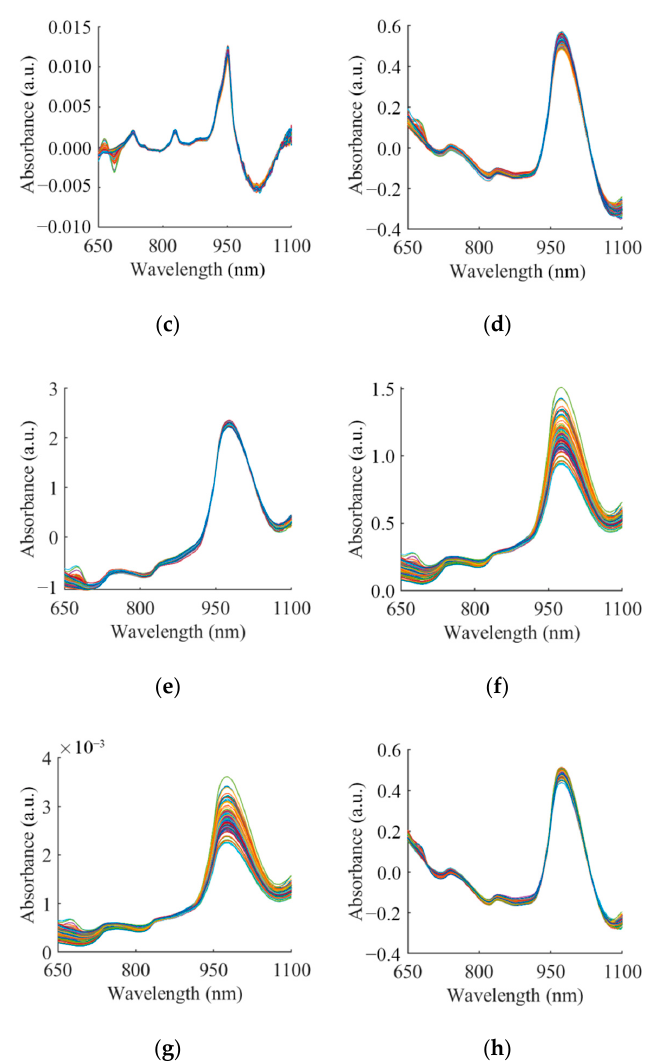
Figure 5. ( a )The raw absorbance spectra (RAW) and the spectra after ( b ) normalization (NOR), ( c ) first derivative (FD), ( d ) deterred (DET), ( e ) standard normal variate (SNV), ( f ) multiplicative scatter correction (MSC), ( g ) probabilistic quotient normalization (PQN), and ( h ) modified optical path length estimation and correction (OPLECm) pretreatment methods. a.u. stands for arbitrary unit.